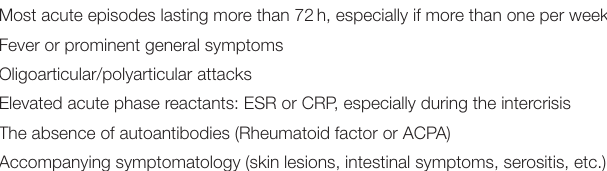
TABLE 4 | Clinical and laboratory data in patients with recurring/relapsing arthritis that should alert the clinician to possible diagnoses other than palindromic rheumatism [modified from Cabrera-Villalba and Sanmarti R (10)]. Most acute episodes lasting more than 72h, especially if more than one per week Fever or prominent general symptoms Oligoarticular/polyarticular attacks Elevated acute phase reactants: ESR or CRP, especially during the intercrisis The absence of autoantibodies (Rheumatoid factor or ACPA) Accompanying symptomatology (skin lesions, intestinal symptoms, serositis,